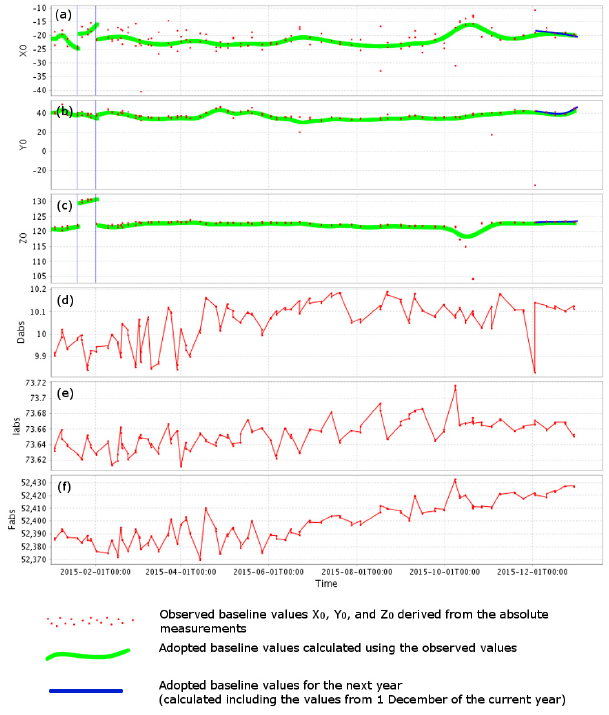
Figure 9. Observed and adopted baseline values (a, b, c) for 2015 and absolute declination (d) , inclination (e) and total intensity (f)